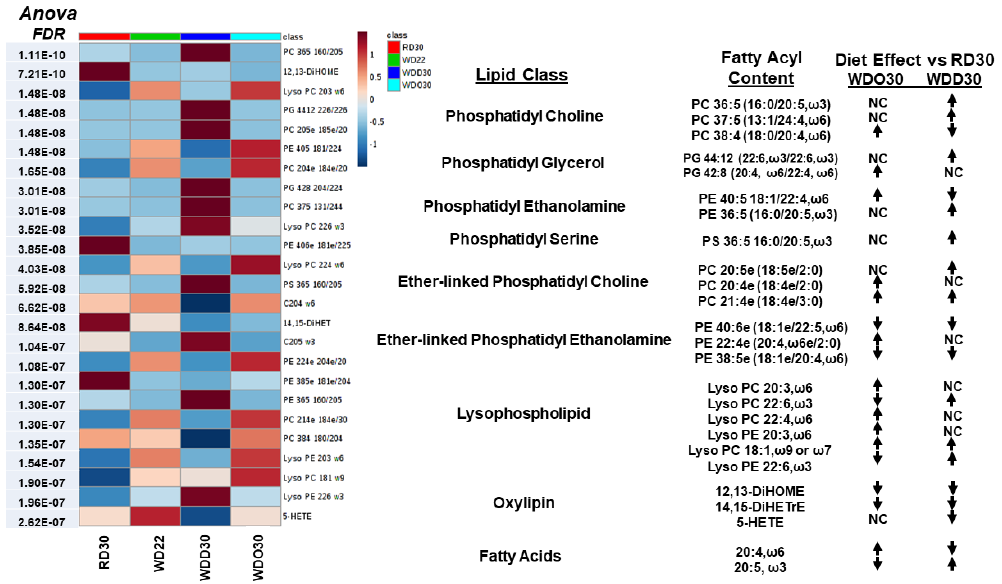
Figure 4. Heat map illustrating diet e ff ects on the top 25 lipid features. As in Figure 3 all lipid data was used to perform an ANOVA (one-way) and a heat map was constructed using the statistical package in Metabolanalyst features [66]. The top 25 highly significant lipid features are illustrated in the heat map. The q -value for each lipid is on the left side of the heat map. Columns at the right list specific lipids within each lipid class that were on the heat map. Arrows indicate the e ff ect of the diet WDO30 and WDD30 when compared to the RD30 group (increase, decrease, no change (NC)) (WD supplemented with either olive oil (WDO) or DHASCO (WDD)).